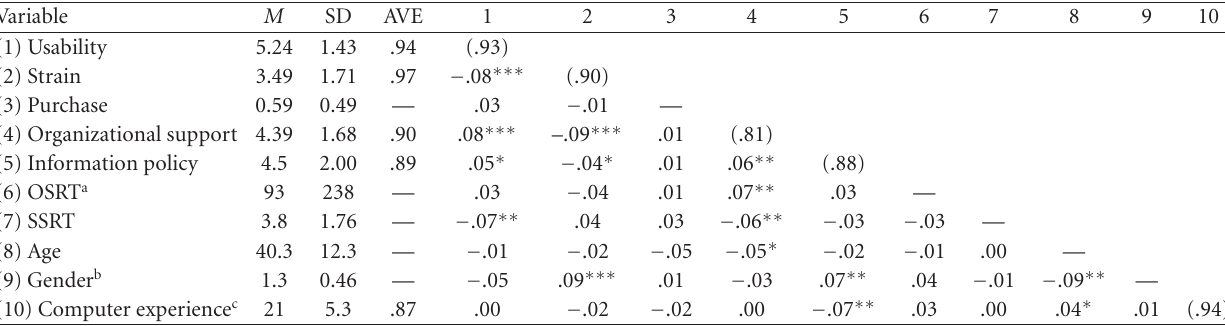
Table 1: Means, standard deviations, average variance extracted, reliability estimates, and intercorrelations among study variable.